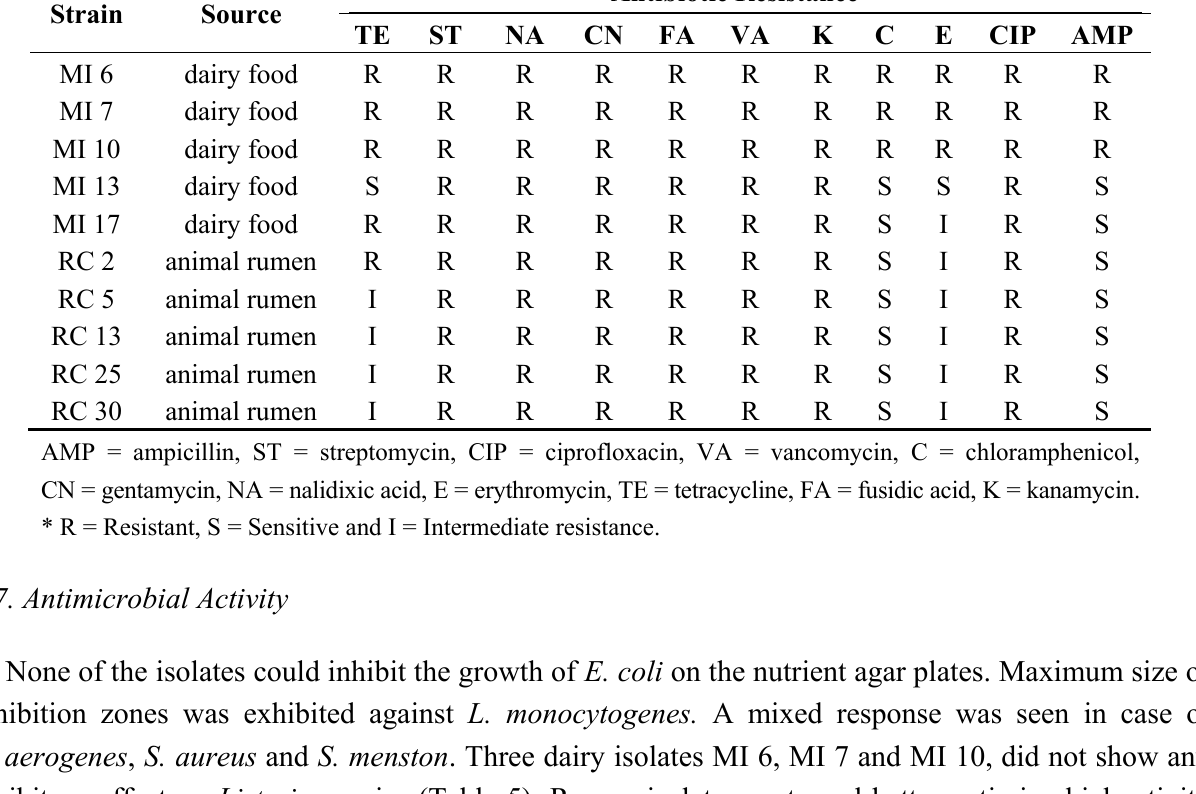
Table 5. Antimicrobial activity profile of strains against various pathogens.